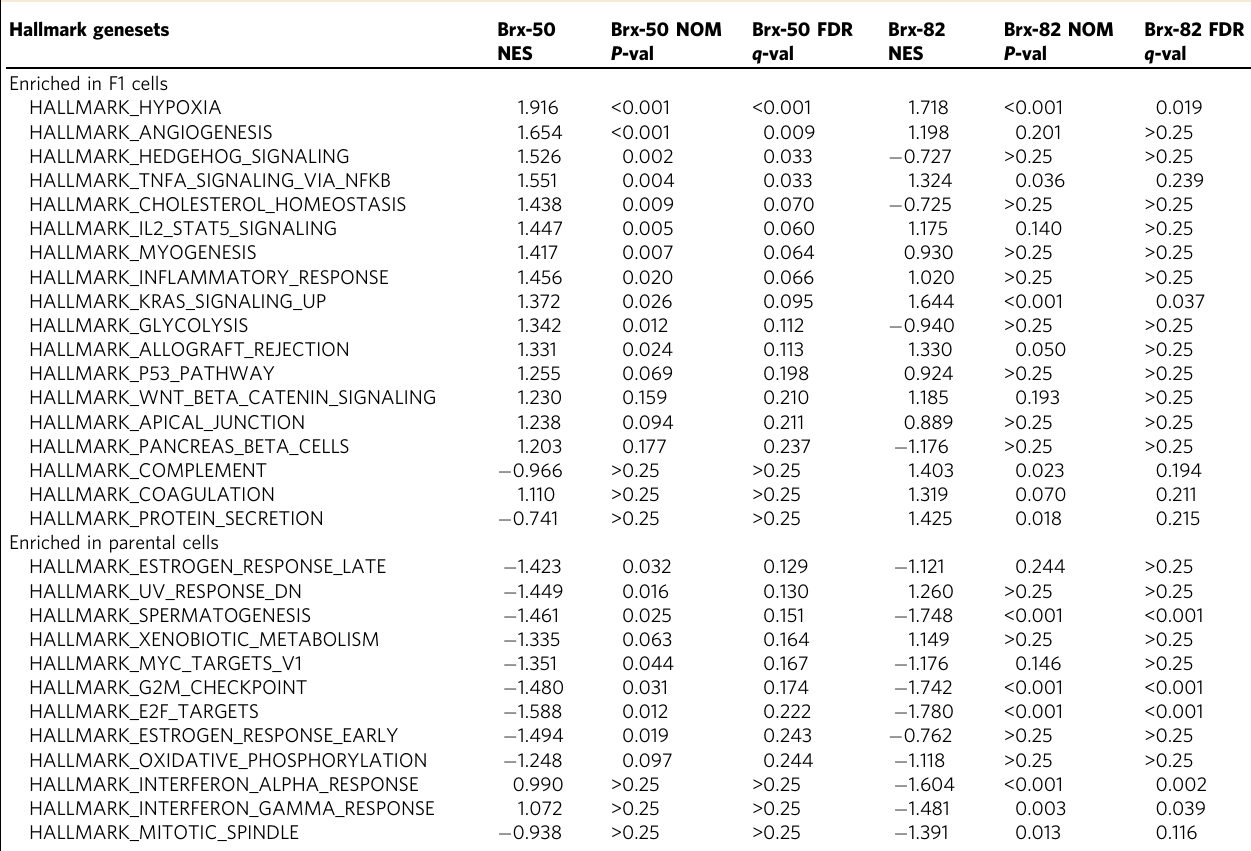
Table 1 F1 cells demonstrate increased hypoxic signaling: GSEA of RNA-seq from Brx-50 and Brx-82, parental and F1 cells for pathways enriched within the Molecular Signatures Database hallmarks of cancer genesets. NES: normalized enrichment score. NOM P -val: nominal P value. Hallmark